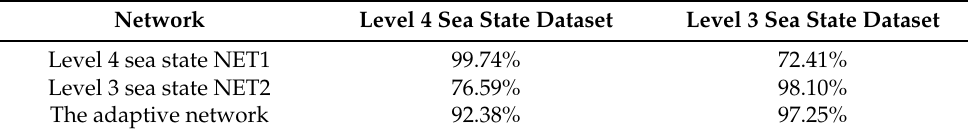
Table 5. Target detection probability of each